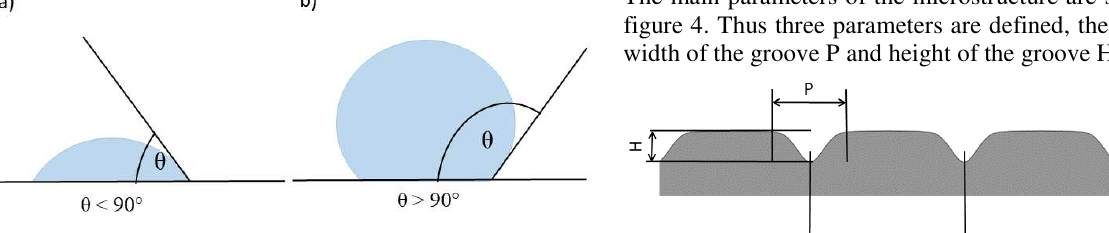
Fig. 2. Hydrophilic (a) and hydrophobic (b) surface .